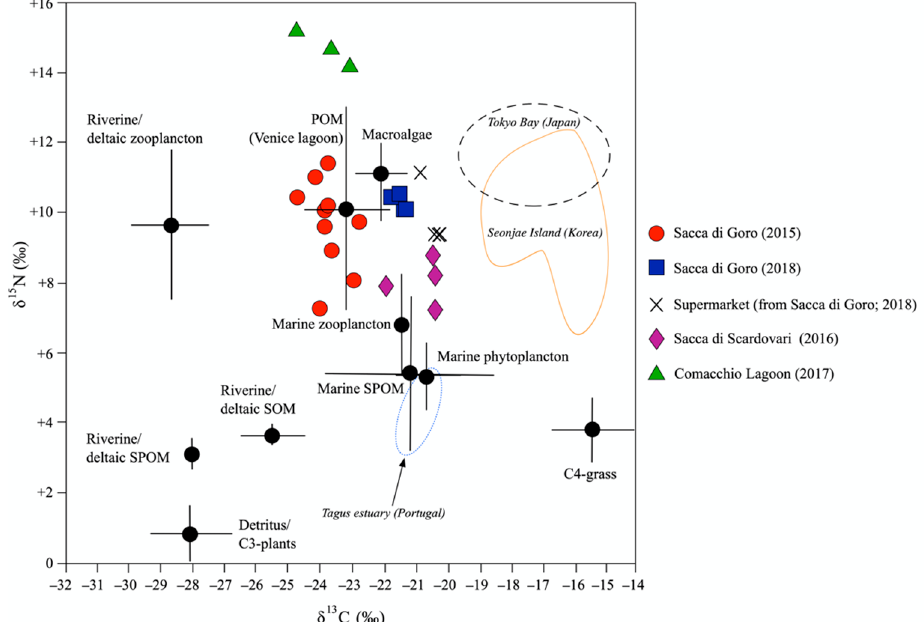
Figure 3. Comparison of carbon (C) and nitrogen (N) isotopic compositions of manila clam tissues from northern Adriatic lagoons with those from (i) fisheries worldwide (Tagus estuary, Portugal [30]; Tokyo Bay, Japan [44]; Seonjae Island, Korea [45]) and with (ii) potential organic sources collected in the Po delta area [38] and in the Venice lagoon [39]. The analytical uncertainties are negligible at the graphical scale.